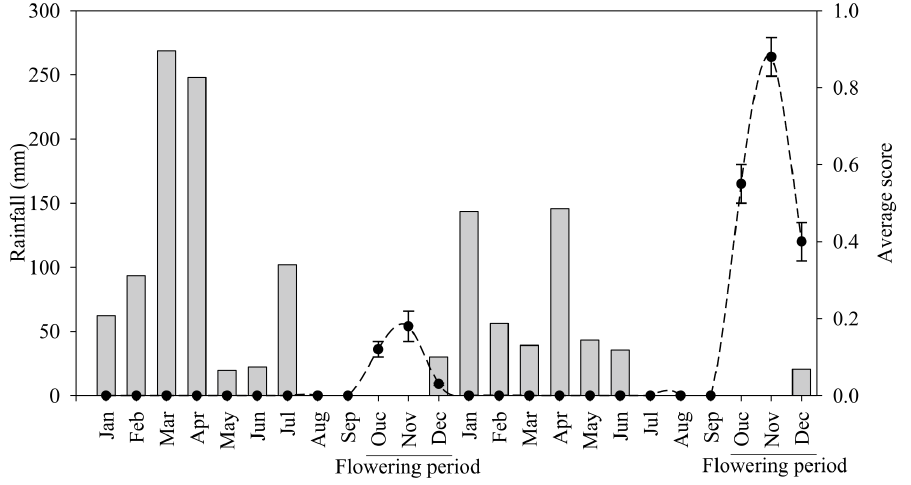
Figure 2. Average score (and corresponding standard errors) of A. occidentale leaves infested by H. fulvus , as well as monthly rainfall (mm), between January 2015 and December 2016. Flowering period corresponds to the inflorescence and